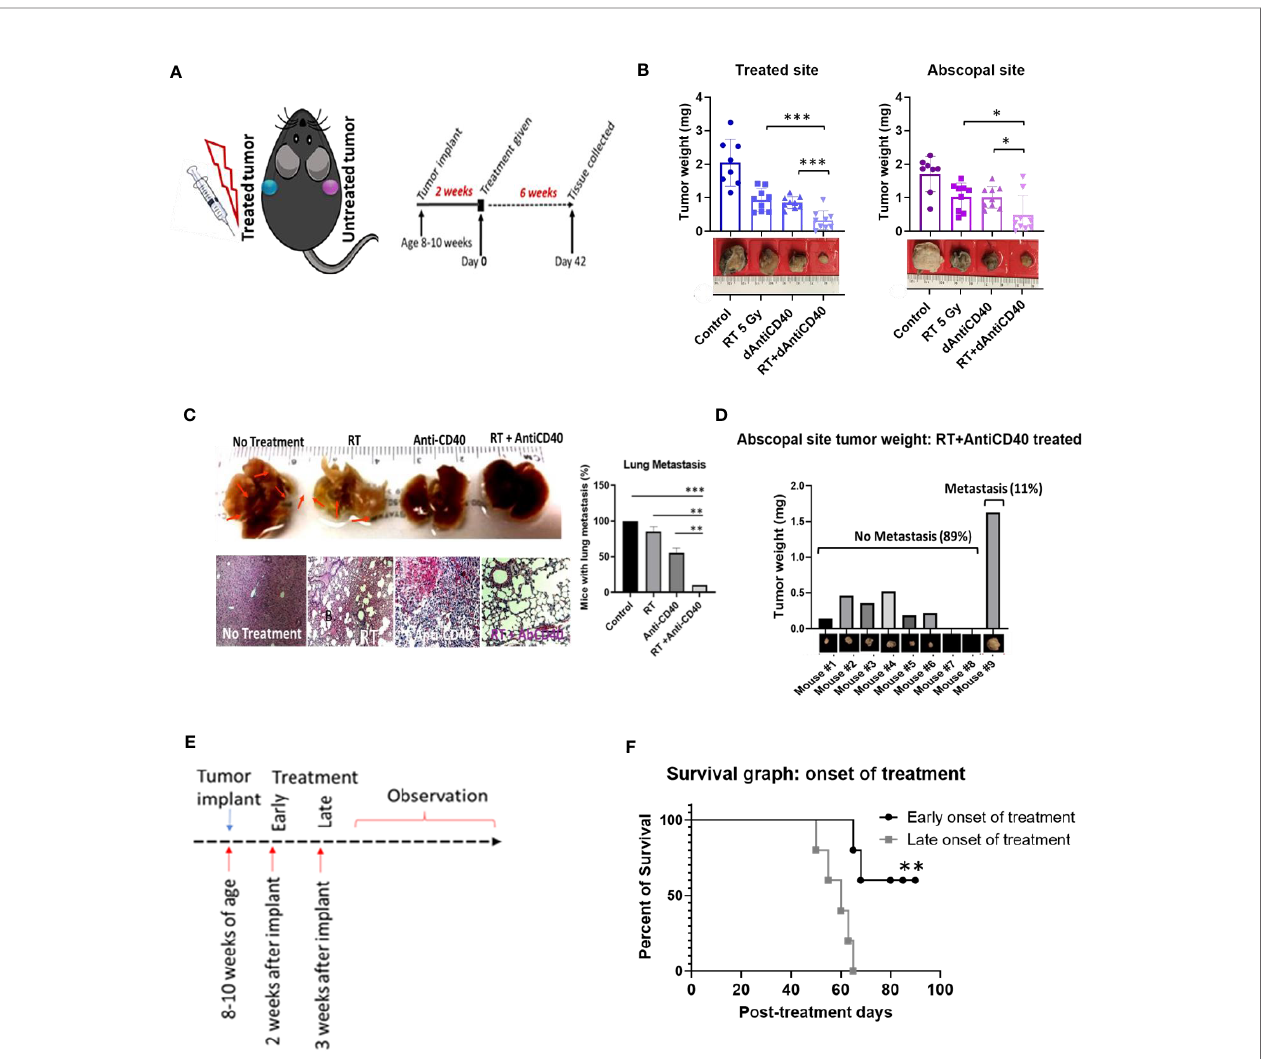
FIGURE 1 | Anti-CD40+RT generates effective in situ vaccination (abscopal effect) and can prevent distant lung metastasis. (A) Cartoon showing mouse treatment model with two pancreatic tumors in two fl anks where only one tumor was treated and experimental schedule of the study observed for 6 weeks posttreatment of 5 Gy of IGRT or dAntiCD40 (20 µg), or the combination (RT+dAntiCD40), along with a control. (B) Showing ex vivo tumor weight of treated and untreated secondary/abscopal tumors, 6 weeks posttreatment. Inset, pictures of the representative tumors. Here, the developed palpable sized one of the subcutaneous tumors was given 5 Gy of IGRT ( n = 8) or dAntiCD40 ( n = 8), or RT+dAntiCD40 ( n = 9). Antimouse CD40 antibody was injected intratumorally with of 20 µg in PBS for a single time. The control group ( n = 8) was injected with same volume of PBS. (C) . Macroscopic view (top) and hematoxylin and eosin-stained microscopic/histological view (bottom) of ex vivo lungs of the same group of mice, which were harvested 8 weeks postimplant (6 weeks posttreatment) and fi xed in 10% formalin. Twenty-four-hour formalin-treated tumors were imaged for macroscopic pictures. For histological analysis, samples were imbedded in paraf fi n for tissue processing and generated 0.5-mm-thick slides. Scale bar represents 100 µm. A bar graph showing number of mice in each treatment group with microscopic lung metastases 8 weeks after tumor implantation. (D) Bar graph showing tumor weight of the abscopal response (untreated) tumors of the combination treated (RT+dAntiCD40) group corelating with presence of lung metastasis shown in histological analysis. (E) study design for the treatment timing showing early (2 weeks post implant) and late (3 weeks post implant) treatment onset with the combination treatment group (RT+dAntiCD40). (F) . Kaplan Meier survival graph for early and late treatment onset of combination treatment with RT+dAntiCD40 in pancreatic adenocarcinoma mouse model ( n = 5). * p < 0.05, ** p < 0.01, and *** p < 0.001. Error bars are SD. *** p <